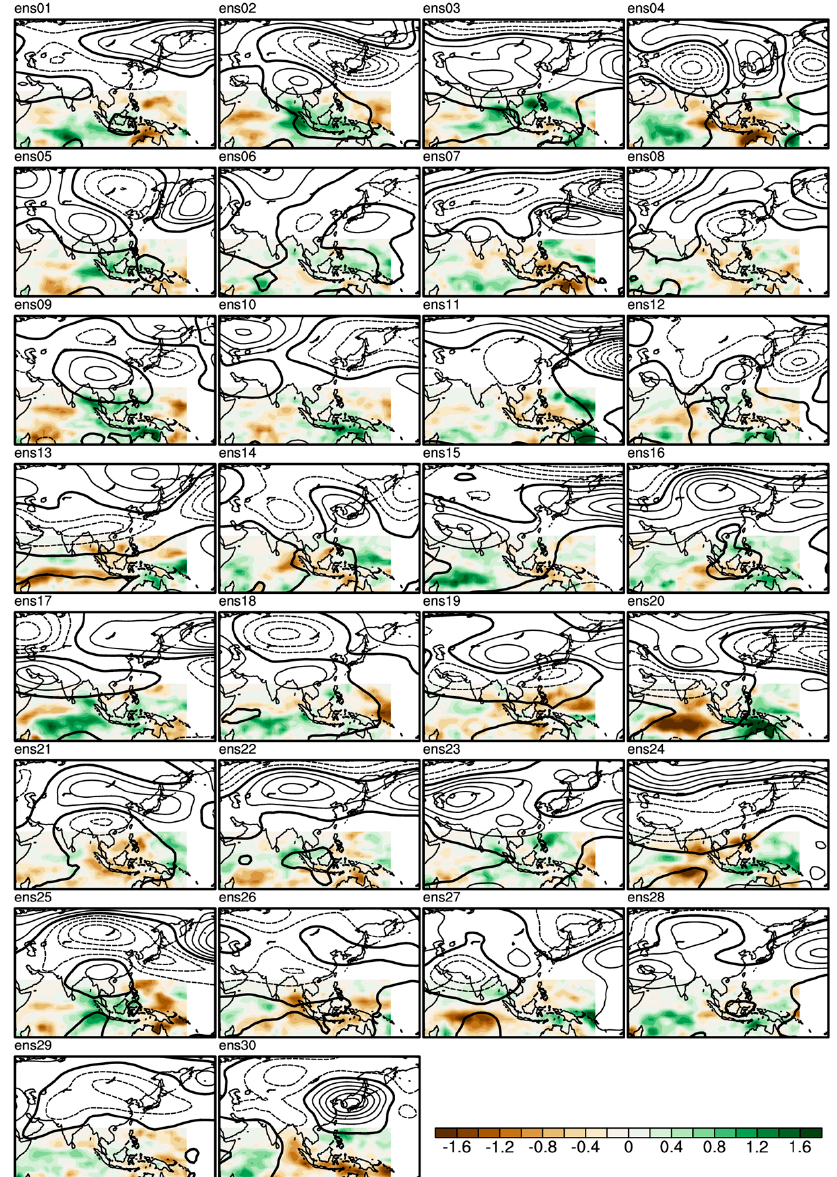
Figure 6. Internal components of rainfall dipole (shading) and IWP–EA pattern (contours; int: 5 gpm) in each model run. Note that the color bar is different from that in Figure 2.